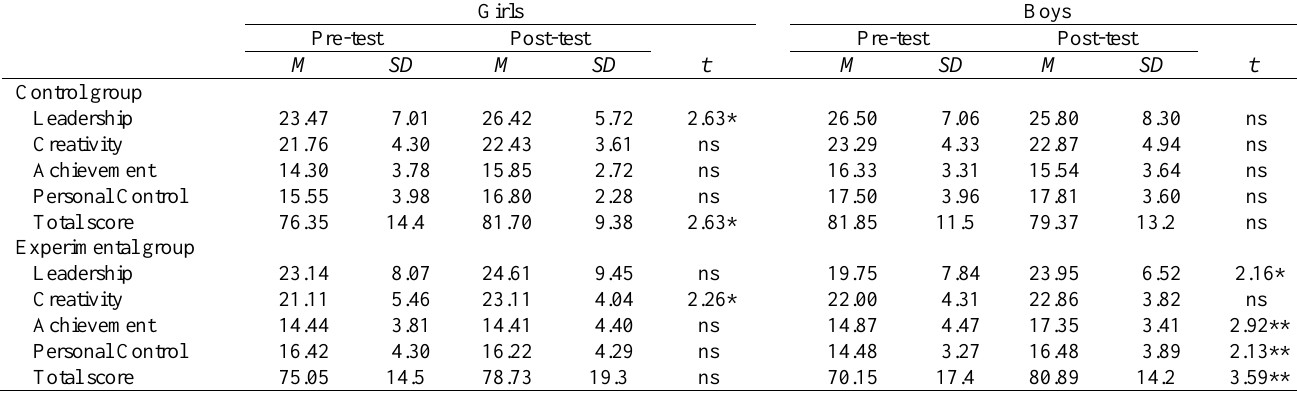
Table 5: ATE test factors: Paired-comparisons t-test by gender for control and experimental groups